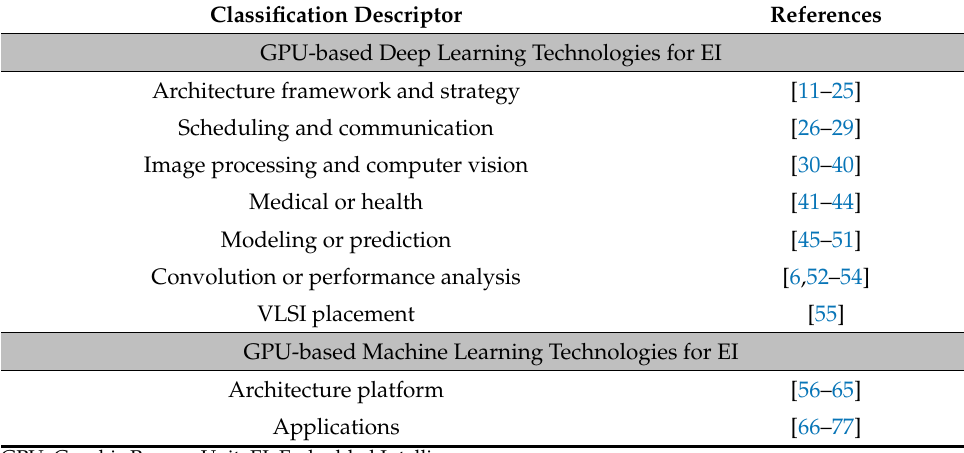
Table 1. Classification Descriptors for Embedded Intelligence Research on